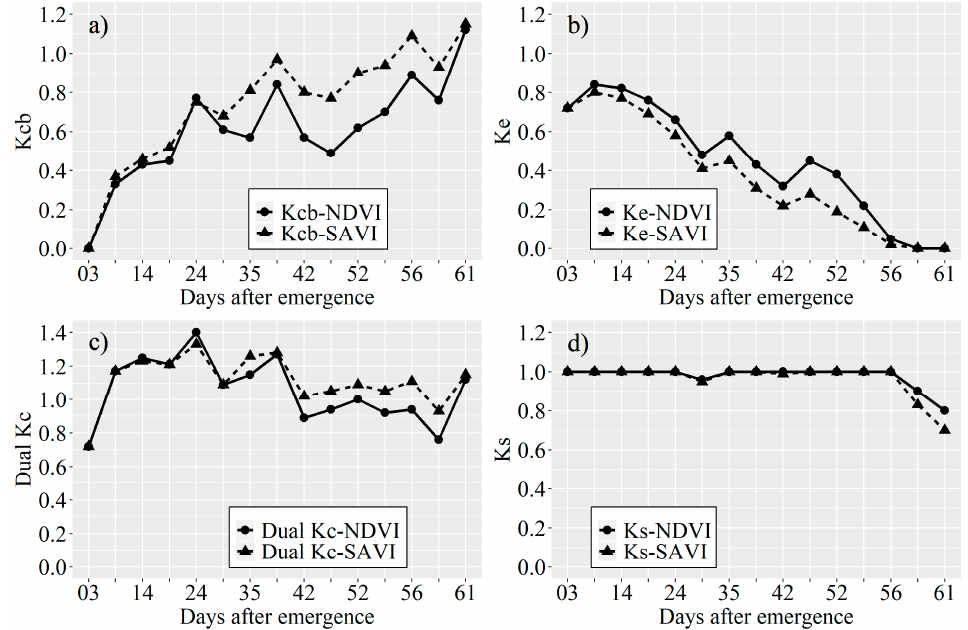
Figure4. MeanvaluesofK cb ( a ), K e ( b ), dualK c ( c ), andK s ( d Figure 4. Mean values of K cb ( a ), K e ( b ), dual K c ( c ), and K s ( d ) for the maize crop 61 days after emergence.